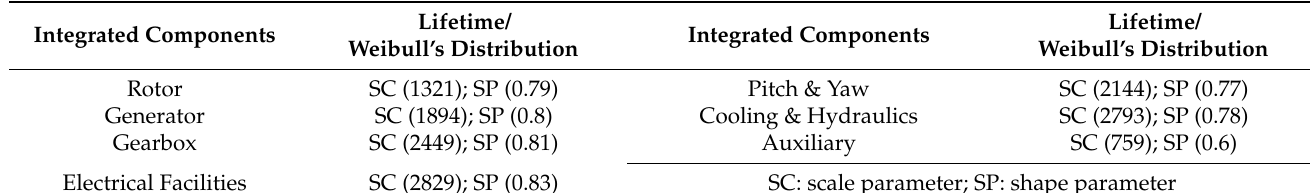
Table 7. Lifetime distribution of components (in the early failure